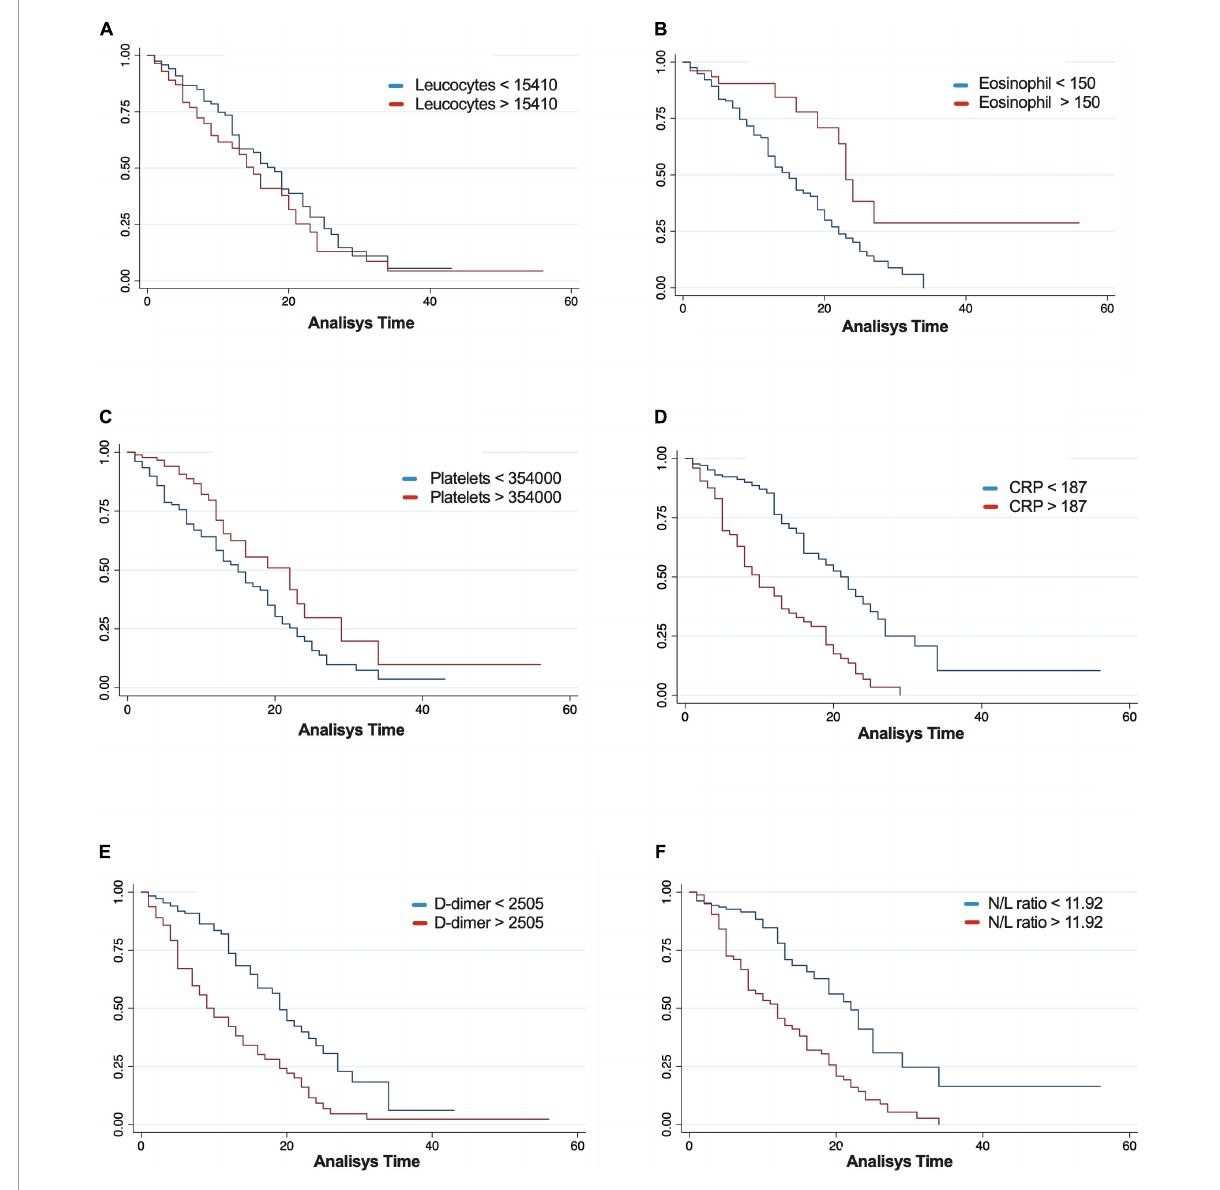
FIGURE3 Kaplan–Meier survival estimates for leukocytes (A) , eosinophil (B) , platelets (C) , C-reactive protein (CRP) (D) , D-dimer (E) , and neutrophil-to-lymphocyte ratio (N/L ratio) (F) .